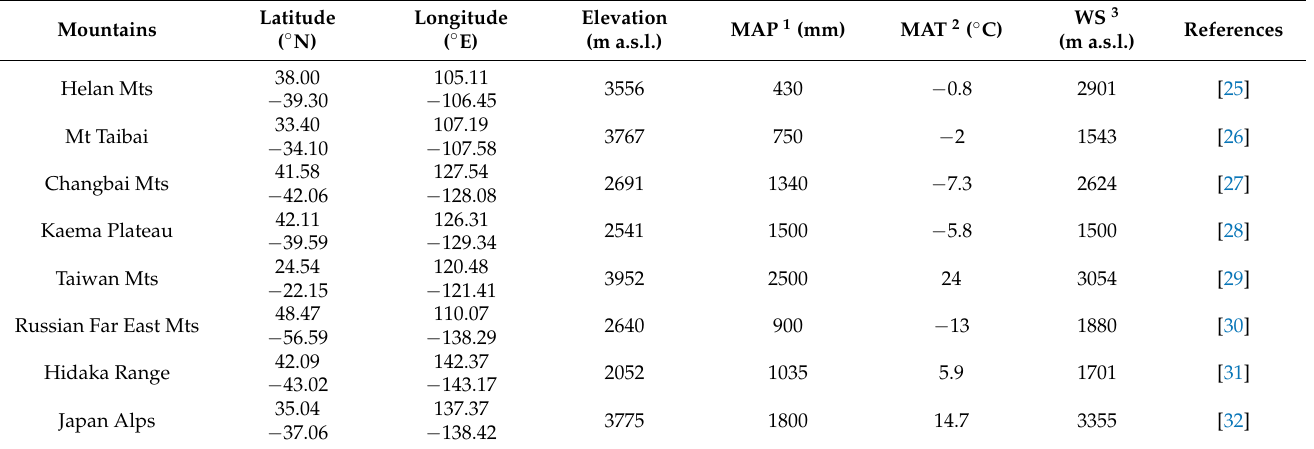
Table 1. Physical geography of the study area.